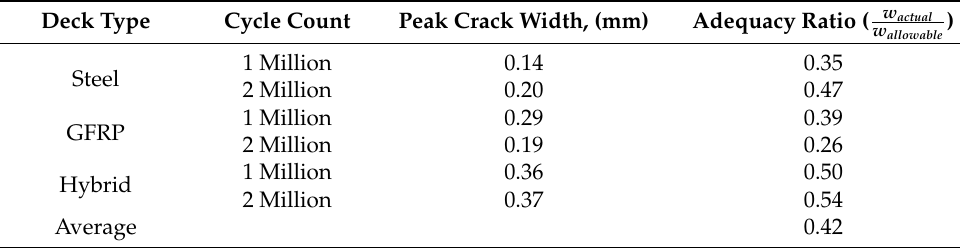
Table 8. Adequacy of bridge decks for crack